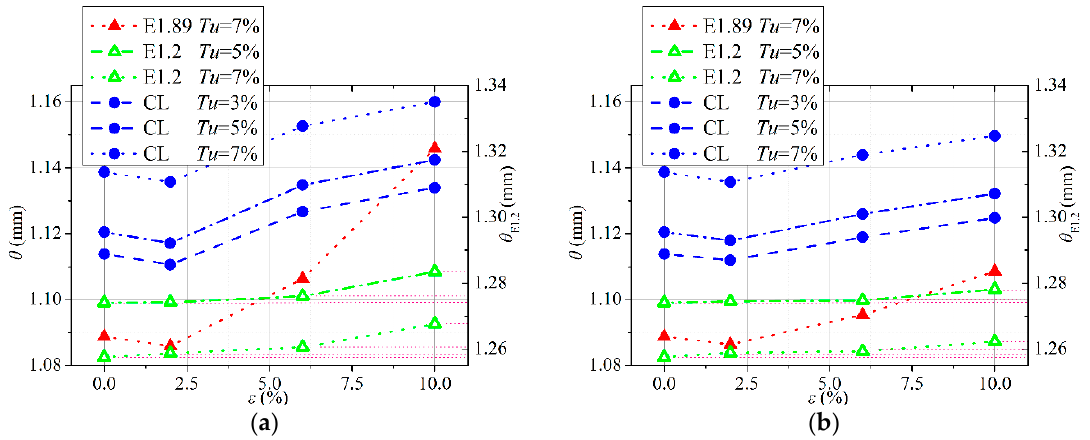
Figure 17. The θ of different leading edges at the point of S = 50 in the high turbulence condition: ( a ) BLUNT series; ( b ) WEDGE series.